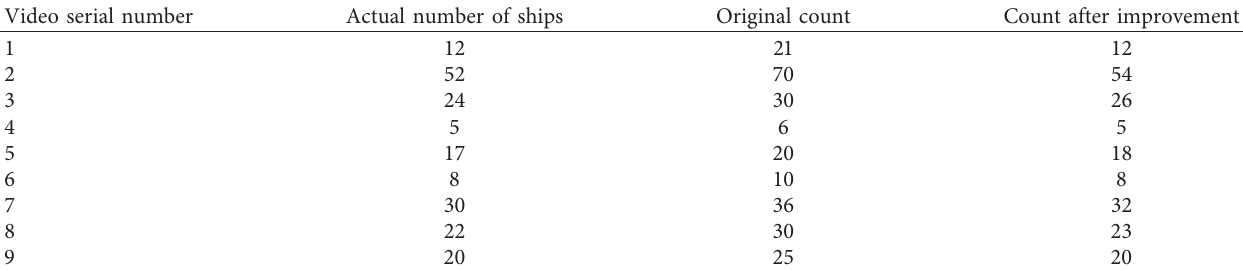
Table 3: Comparison of counting effects before and after applying the self-correction algorithm. Video serial